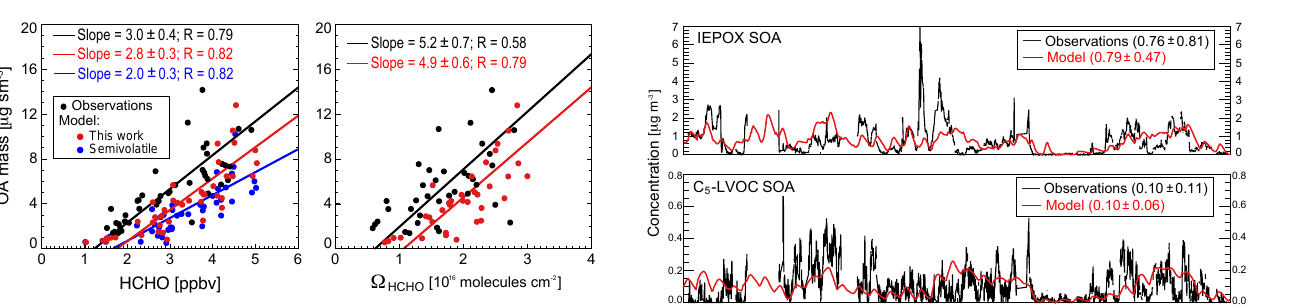
Figure 3. Relationship of organic aerosol (OA) and formaldehyde (HCHO) concentrations over the southeast US in summer. The fig- ure shows scatter plots of SEAC 4 RS aircraft observations of OA concentrations in the boundary layer ( < 2km) vs. HCHO mix- ing ratios measured from the aircraft (left), and column HCHO ( (cid:127) HCHO ) retrieved from OMI satellite observations (right). Indi- vidual points denote data from individual SEAC 4 RS flight days (8 August–10 September), averaged on the GEOS-Chem grid. OMI data are for SEAC 4 RS flight days and coincident with the flight tracks. GEOS-Chem is sampled for the corresponding locations and times. Results from our simulation with aqueous-phase isoprene SOA chemistry are shown in red, and results from a simulation with the Pye et al. (2010) semivolatile reversible partitioning scheme are shown in blue. Aerosol concentrations are per m 3 at standard con- ditions of temperature and pressure (273K; 1atm), denoted sm − 3 . Reduced major axis (RMA) regressions are also shown with regres- sion parameters and Pearson’s correlation coefficients given inset. 1 σ standard deviations on the regression slopes are obtained with jackknife resampling.